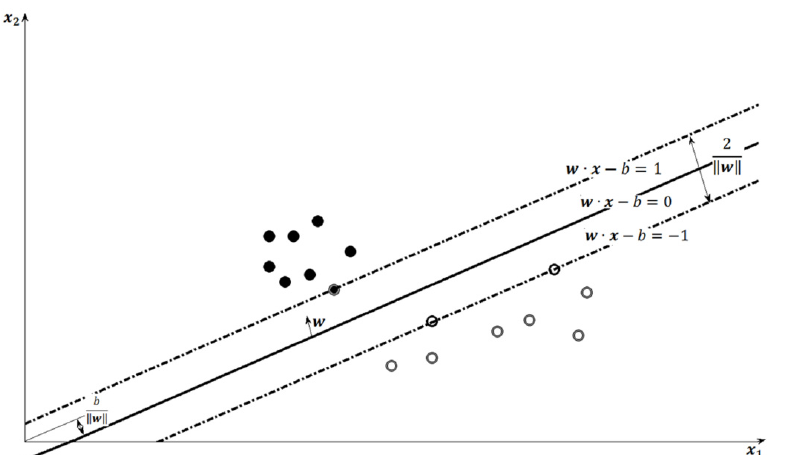
Figure 6. Maximum-margin hyperplane and margins for an SVM trained with samples from two classes. Samples on the margin are called the support vectors. Clusters are highly enriched by means of the 50-frame multi-view procedure. A cluster of 50 points is formed when the person is sober and the another one when the person is drunk.